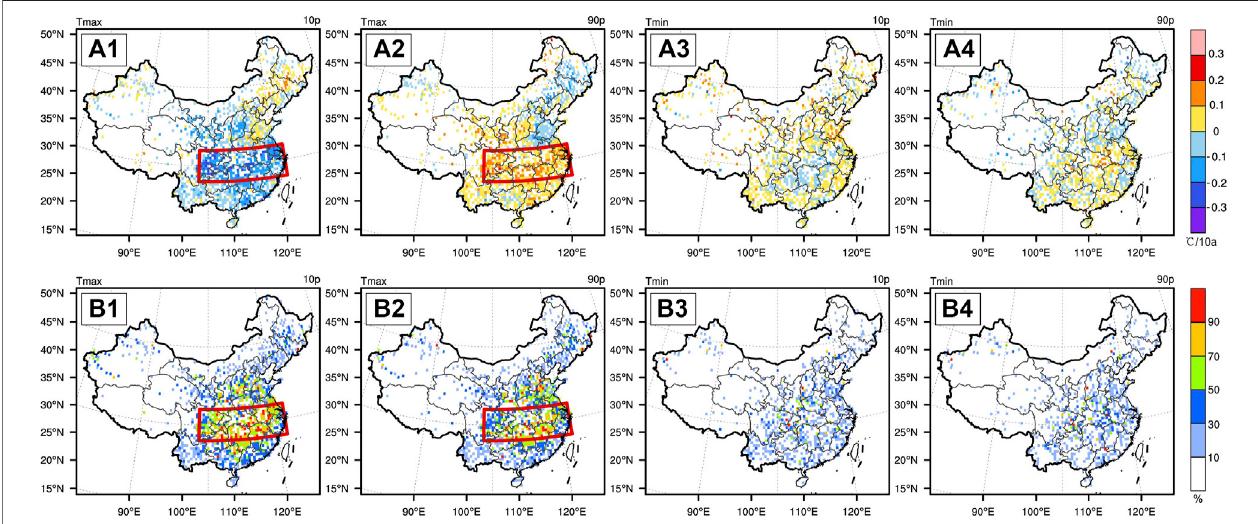
FIGURE 4 | The quantile trends of Tmax (A1,A2) and Tmin (A3,A4) at 10th and 90th percentiles due to the changing shape of temperature distribution and their relative contributions [Tmax: (B1,B2) ; Tmin: (B3,B4) ]. The meaning of red boxes is the same as Figure 1 .